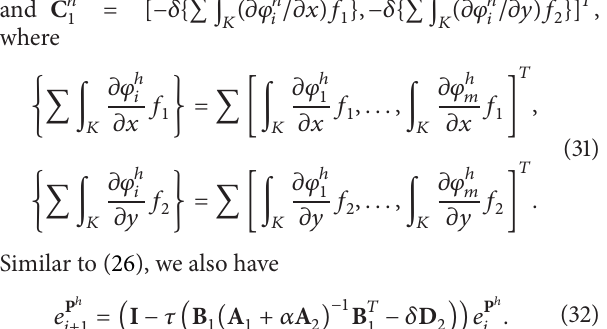
Algorithm III (Multiscale enrichment method). Another sta- bilized way is the multiscale enrichment approach which